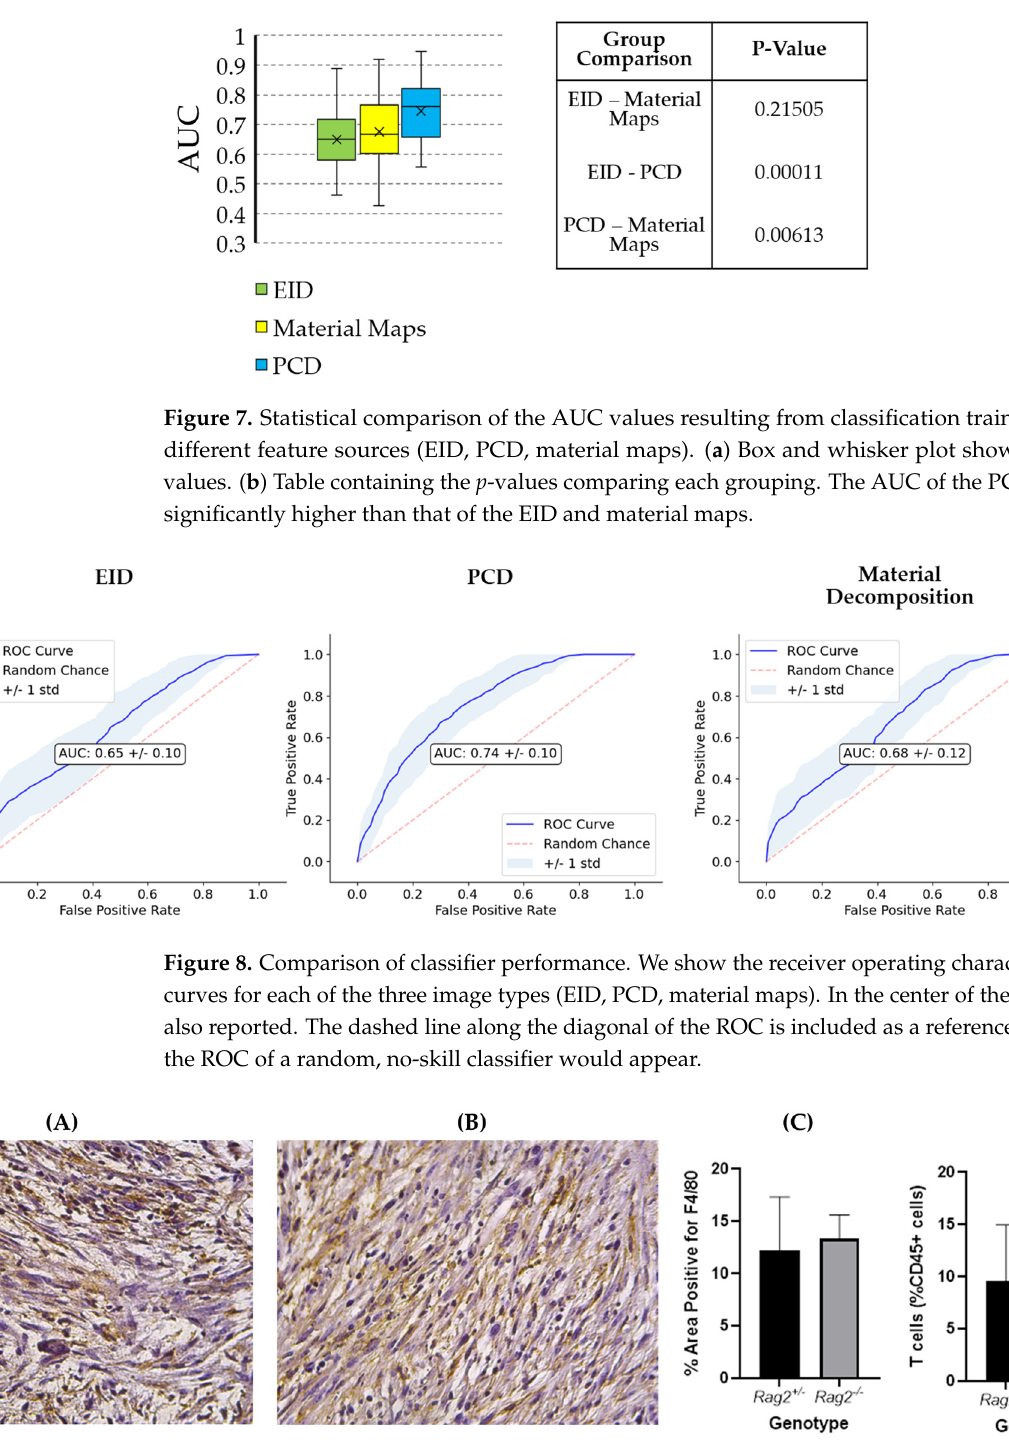
mice stained with F4/80 (macrophage marker). The slides were analyzed and the percentage area positive for F4/80 was found not to be significantly different between the two genotypes ( p = 0.62, unpaired t -test) ( C ). Flow cytometry confirmed significantly higher T cell infiltrate in tumors from Rag2 +/ − compared to Rag2 − / − mice ( p = 0.01, unpaired t -test) ( D